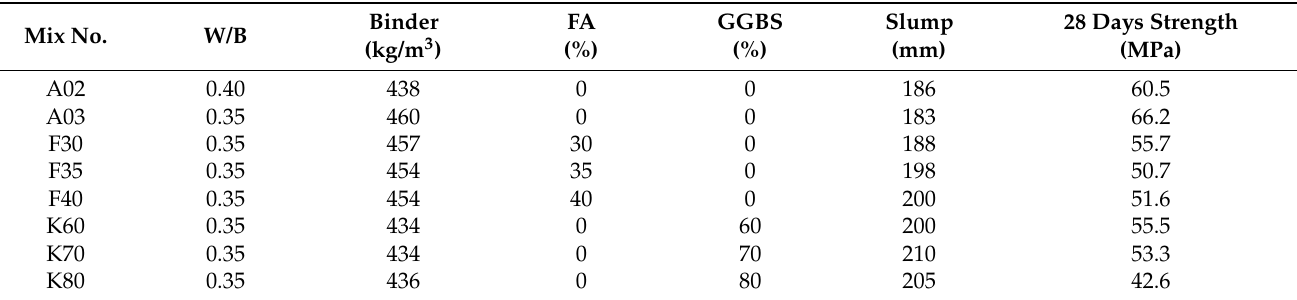
Table 4. Mixture Proportions of